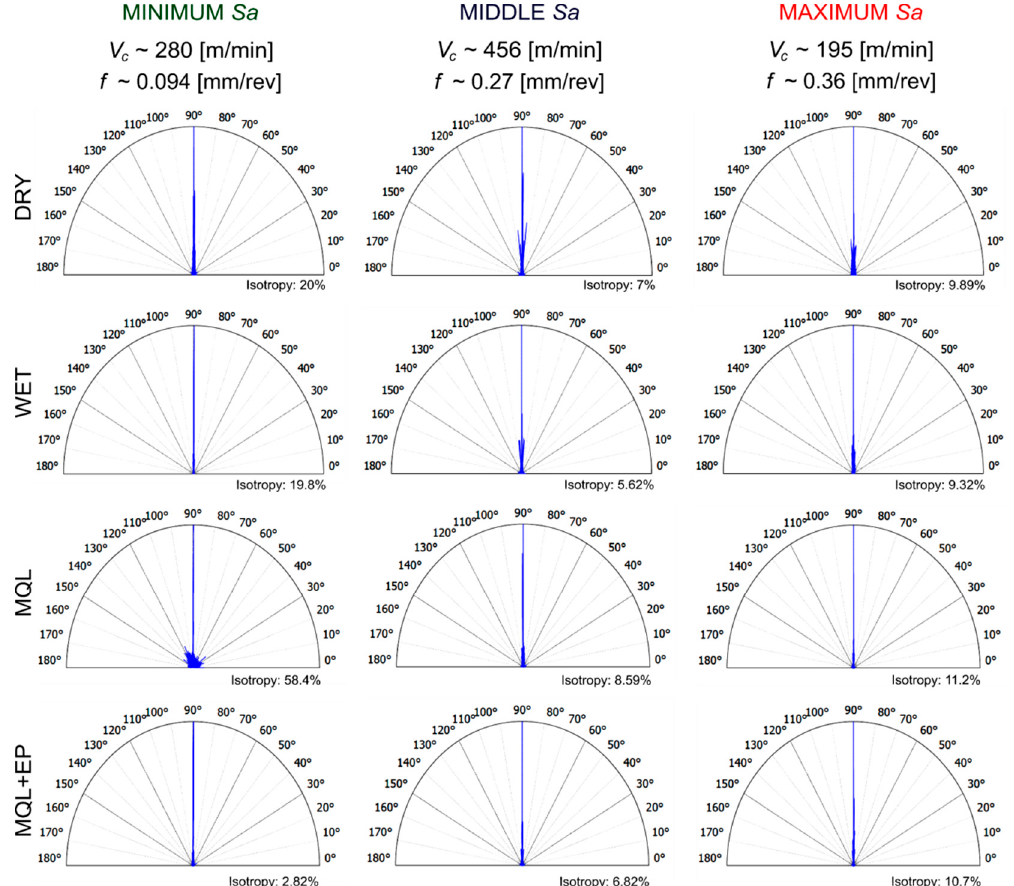
Figure 14. Surface structure direction after finish turning of the steel tested.